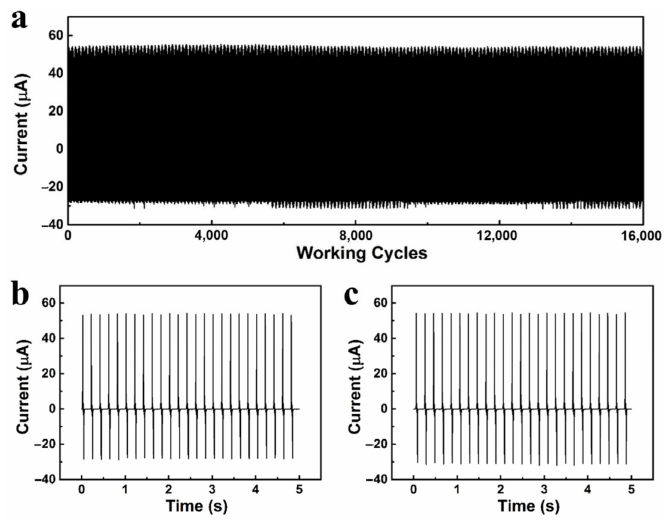
Figure 6. The mechanical stability of the TENG based on hybrid compositions: ( a ) the current for 16,000 working cycles, ( b ) the current for the beginning point, ( c ) the current for the ending